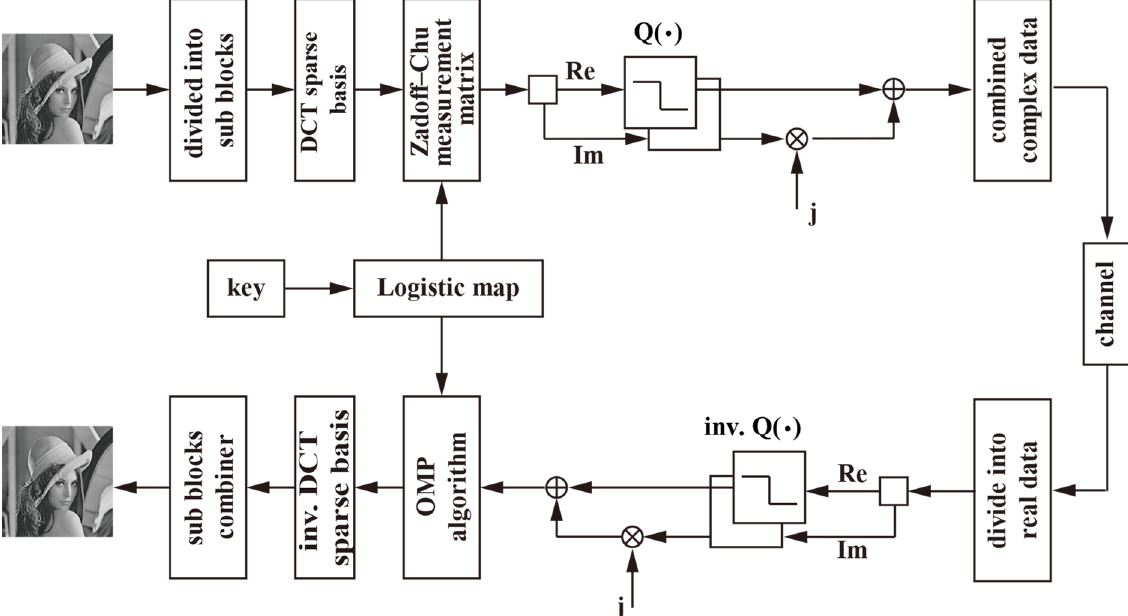
Figure 1. The proposed image-based quantized BCS framework. Step 1: Image block partitioning. The original image of size N × N is divided into non-overlapping blocks of size N B × N B